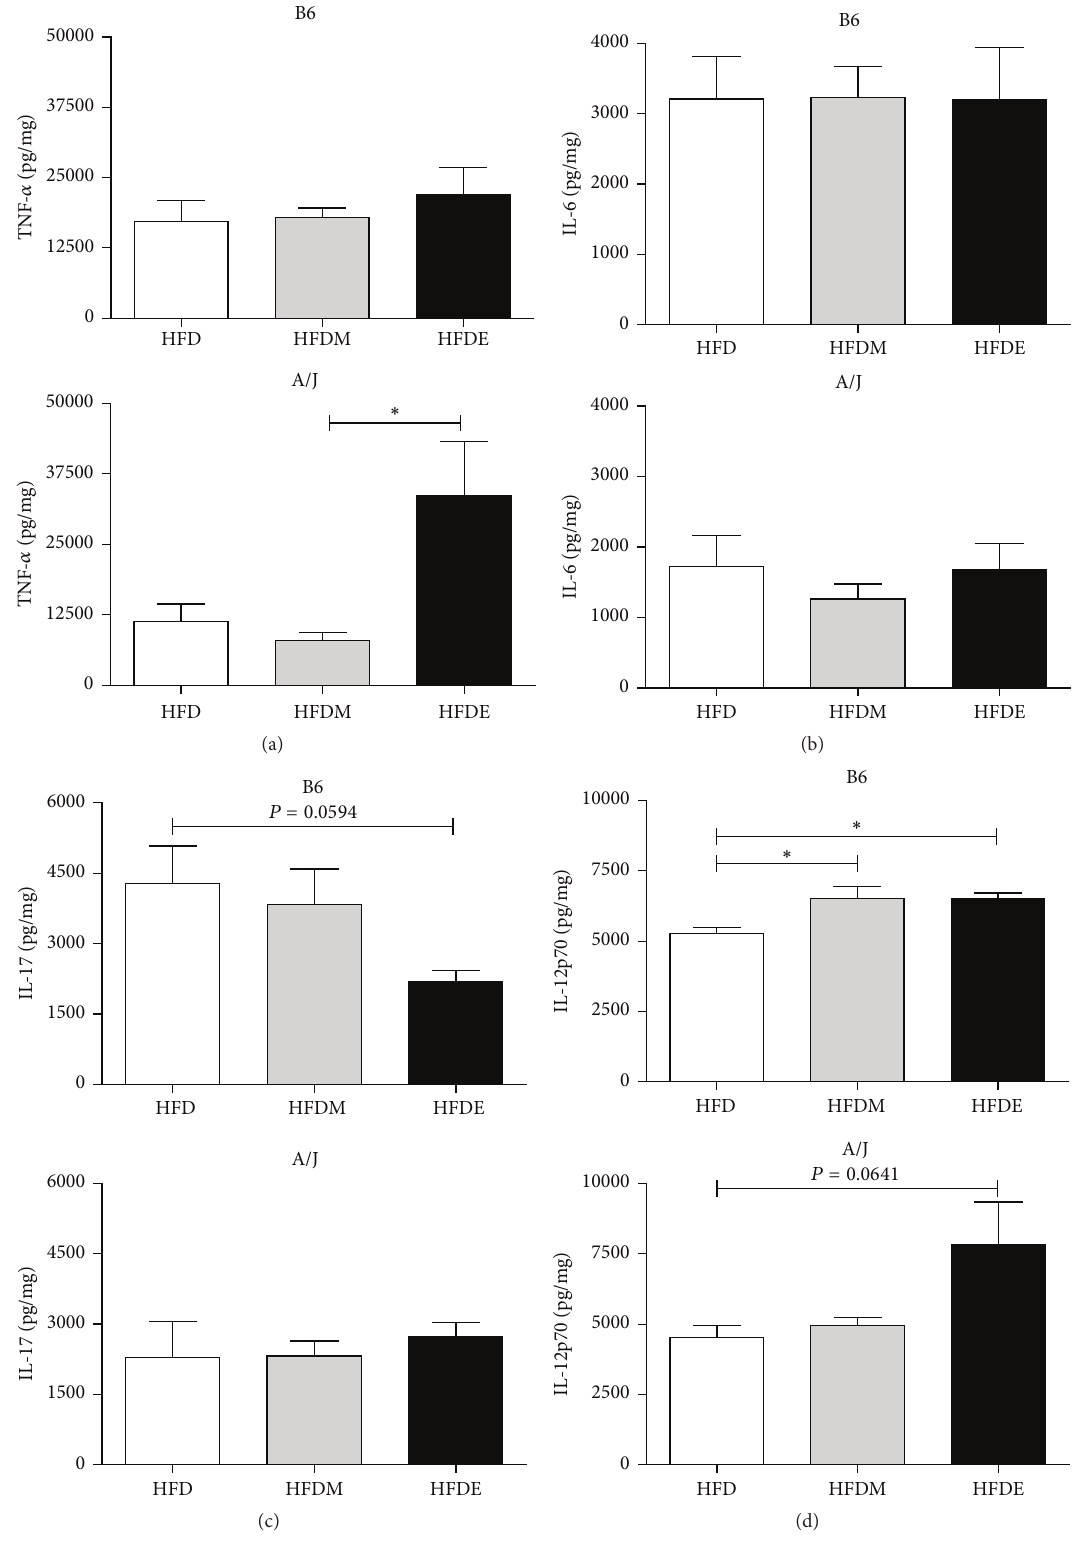
Figure 5: Liver cytokines in B6 and A/J mice after ethanol feeding for 10 weeks. Liver TNF- 𝛼 (a), IL-6 (b), IL-17A (c), and IL-12p70 (d) concentrations in B6 and A/J mice after 10 weeks of HFD, HFDM, and HFDE. Livers were collected and frozen in liquid nitrogen. Lysates were prepared from frozen samples and cytokines (pg/mg protein) were measured by ELISA. Results from both B6 and A/J mice ( 𝑛 ≥ 5 ) were evaluated by ANOVA one-way and Tukey as a posttest. Values represent means and standard error. The differences are represented by ∗ 𝑃 < 0.05 , ∗∗ 𝑃 < 0.01 , and ∗∗∗ 𝑃 < 0.001 . HFD: high fat diet, HFDM: HFD containing maltodextrin, HFDE: HFD containing